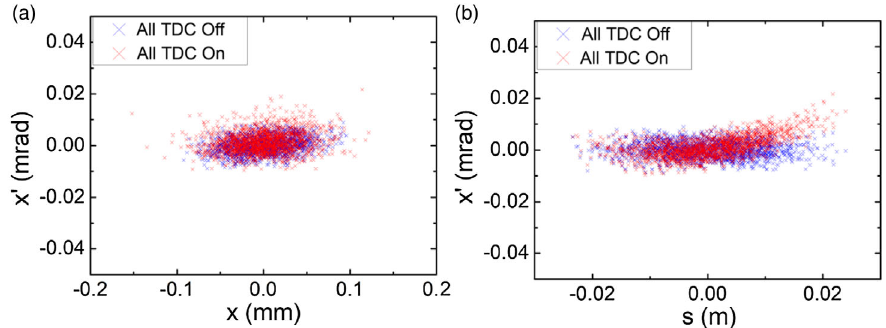
FIG. 7. Particle distributions in the horizontal phase space (a) and horizontal momentum via phase (b) after the second TDC.